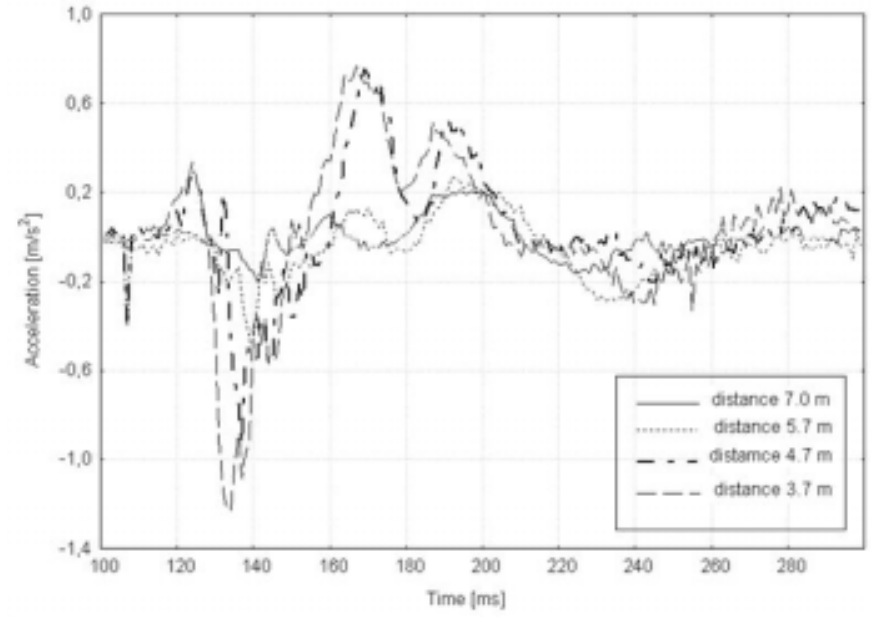
Fig. 26. Time histories of structure acceleration depend on detonation distance charge-silo without barrier.